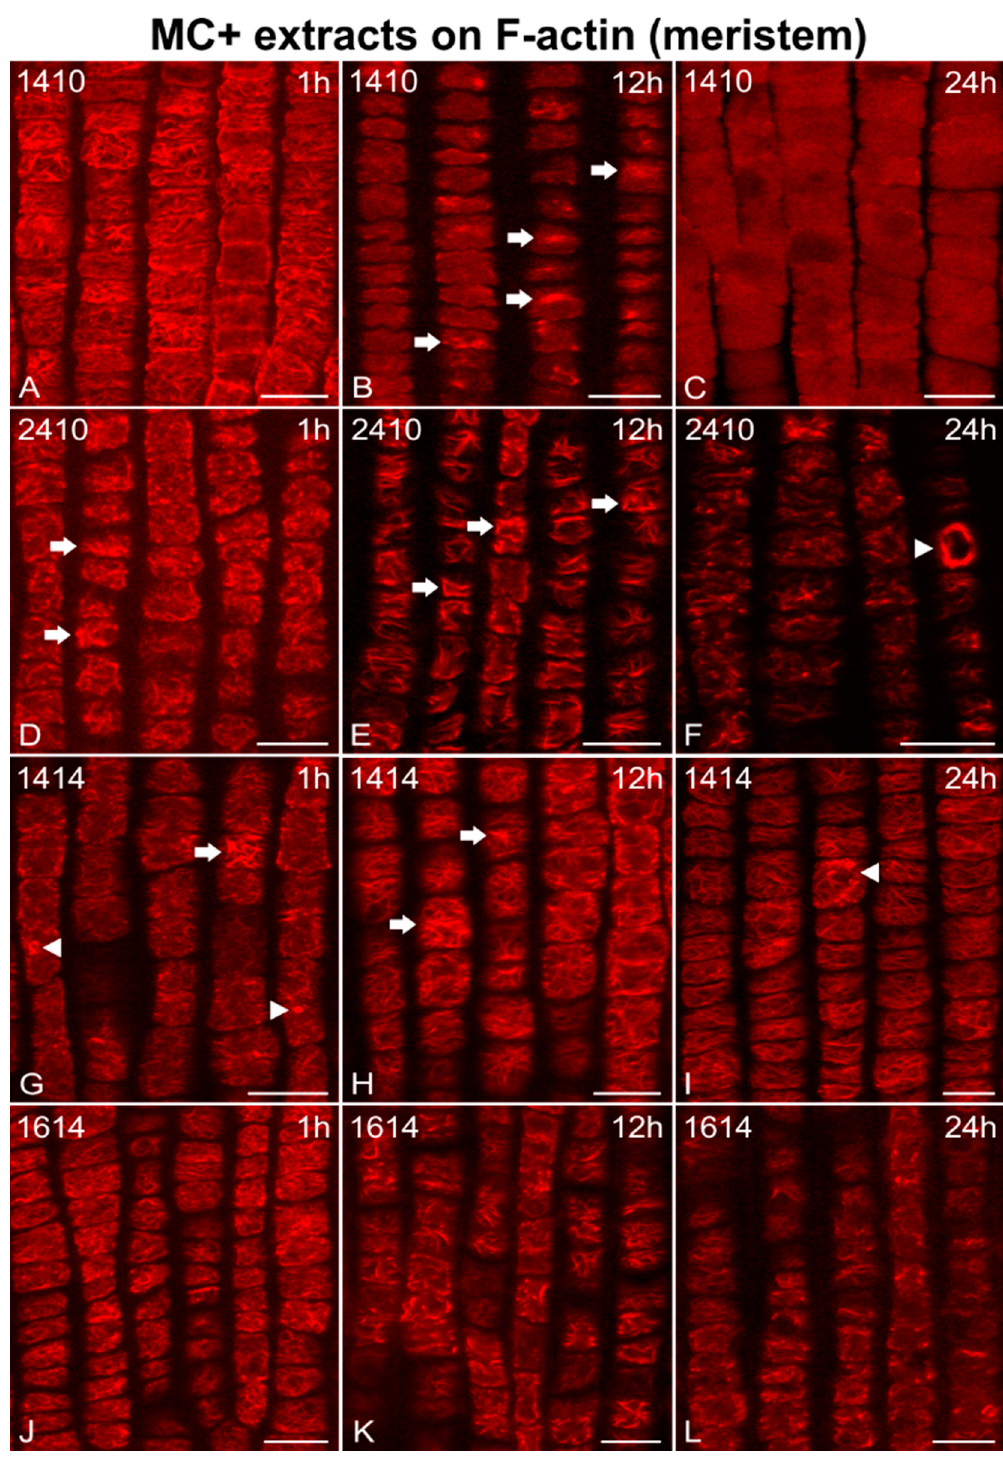
Figure 2. Single cortical CLSM sections of Oryza sativa root protodermal cells stained for F-actin, after treatment with MC+ extracts from various MC-producing strains: Microcystis flos-aquae TAU-MAC 1410 ( A – C ), Microcystis sp. TAU-MAC 2410 ( D – F ), Raphidiopsis raciborskii TAU-MAC 1414 ( G – I ), and Trichormus variabilis TAU-MAC 1614 ( J – L ). Root tips in all images point towards the bottom of the page. After 1 h of treatment, actin filaments were disoriented and branched ( A ; cf. Figure 1A) and tended to form bundles (arrows in D , G ) or even rings (arrowheads in G ). After 12 h, bundling (arrows in B , E , H ) and disorientation ( E , H , K ) appeared intensified. After 24 h, the F-actin network deteriorated significantly ( F , L ) and appeared disoriented ( I ), or even collapsed ( C ). Circular actin aggregates (arrowhead in F ) and ring-shaped conformations (arrowhead in I ) could also be detected. Scale bars: 10 µ